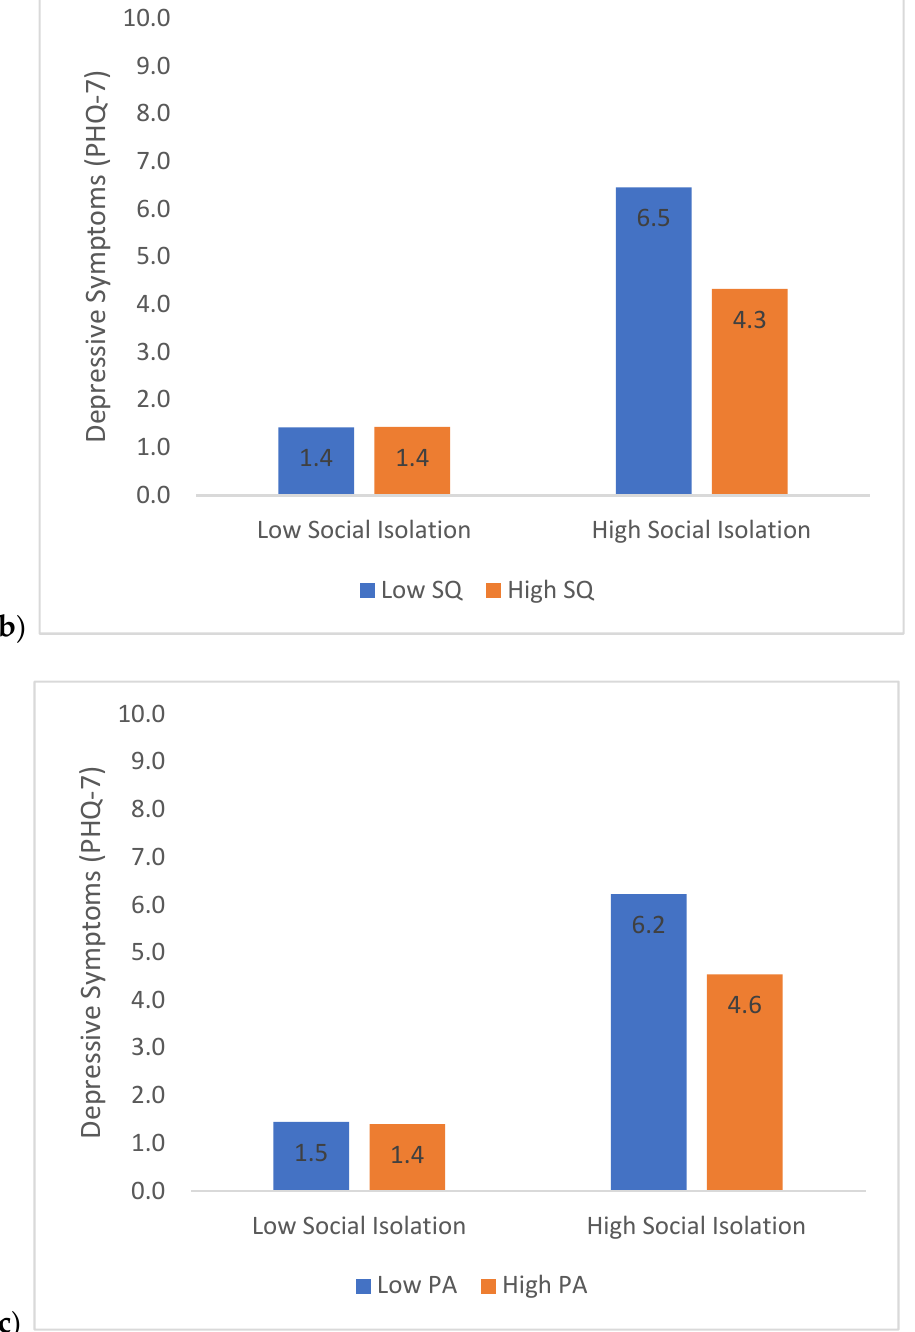
Figure 1. Estimated depressive symptoms (PHQ-7 scores) as a function of the association between social isolation and ( a ) total wake time (TWT), ( b ) sleep quality (SQ), and ( c ) physical activity (PA). High and low social isolation scores represent ± 2 SD from the sample mean ± 2 SD from the sample mean was also used to estimate high and low values for TWT, SQ, and